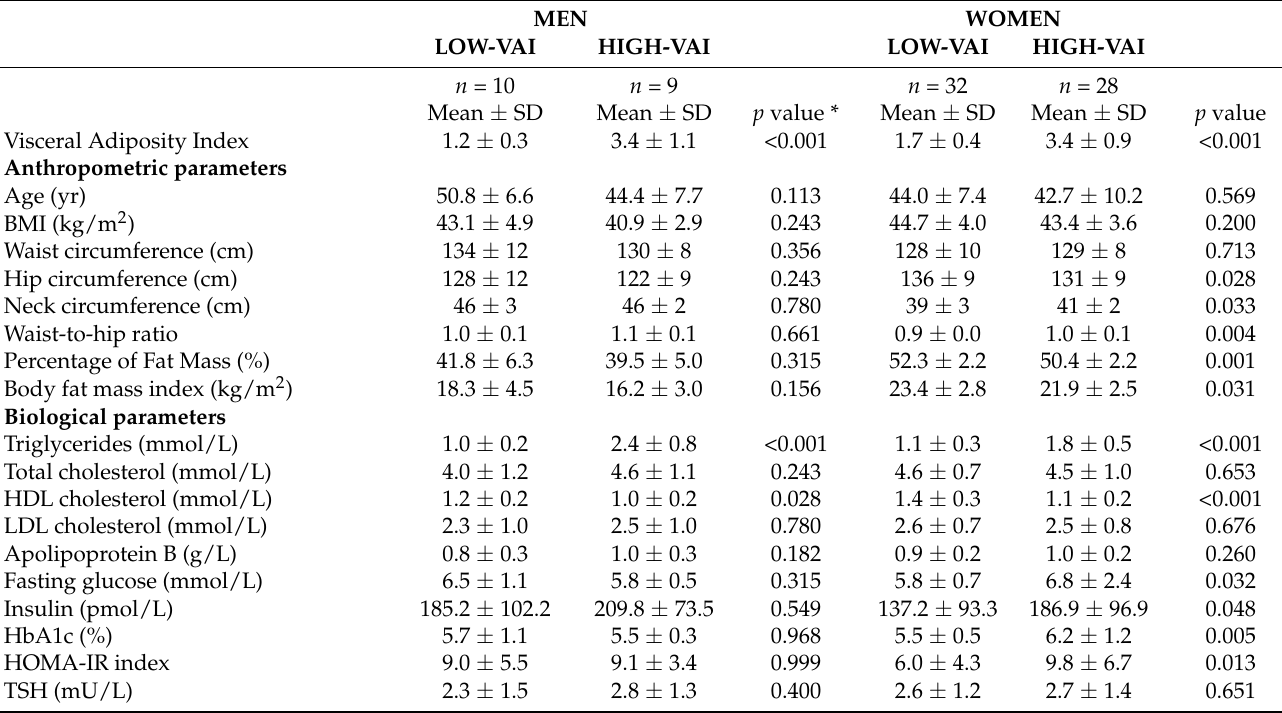
Table 1. Comparison of anthropometric and biological parameters between participants with high- versus low-visceral adiposity index